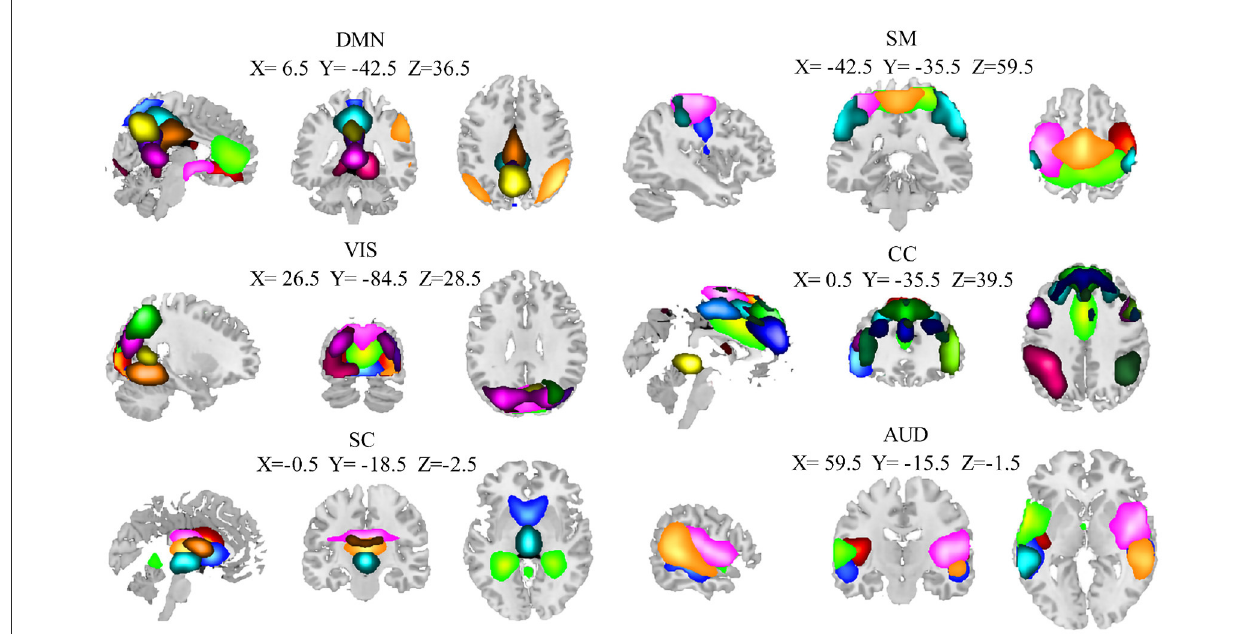
FIGURE2 Spatial maps of the 60 independent components result from the entire group (28 elderly and 34 younger adults). The coordinates denote the max peak location of functional domains, and different colors pass spatial information. AUD, auditory domain; CC, cognitive control domain; DMN, default mode domain; SC, subcortical; SM, sensorimotor domain; VIS, visual